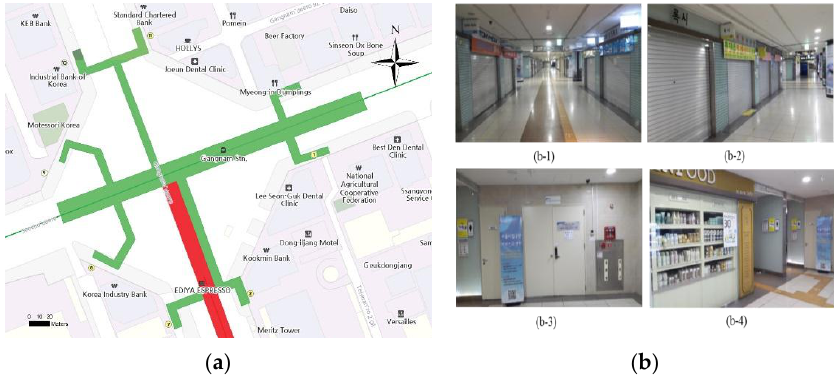
Figure 3. Project site: ( a ) study area; and ( b-1 , 2 , 3 , 4 ) Gangnam subway station underground shopping center; ( b-1 ) circulation space; ( b-2 ) store space; ( b-3 ) facility management space; and ( b-4 ) public restroom.